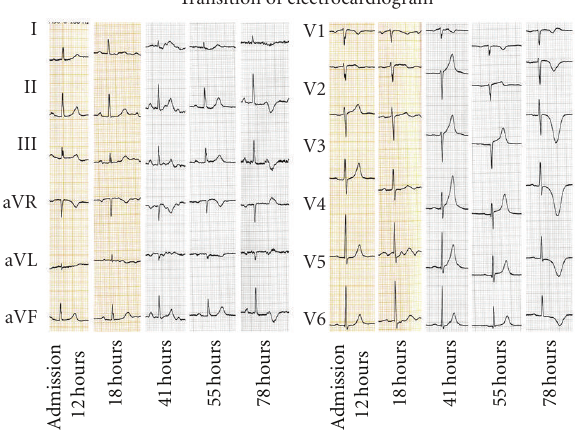
Figure 2: These images show transition of electrocardiogram. Times after ingestion of glufosinate were set as horizontal axes. “41 hours” means the time at onset of Takotsubo cardiomyopathy. Transit ST segment elevation and typical negative T wave were seen in precordial leads through clinical